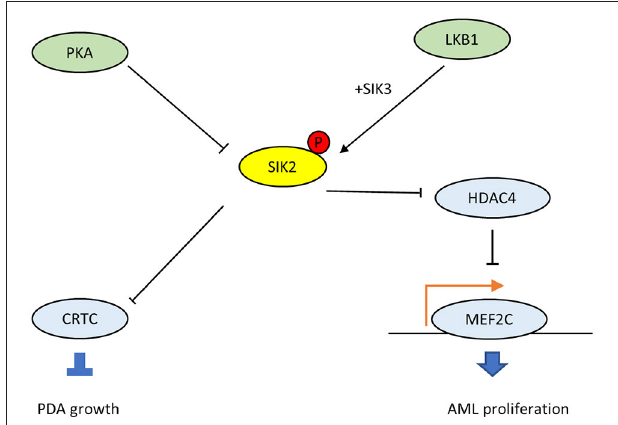
FIGURE 3 | The dichotomous oncogenic roles of SIK2 in the LKB1-HDAC axis and the cAMP-PKA axis.